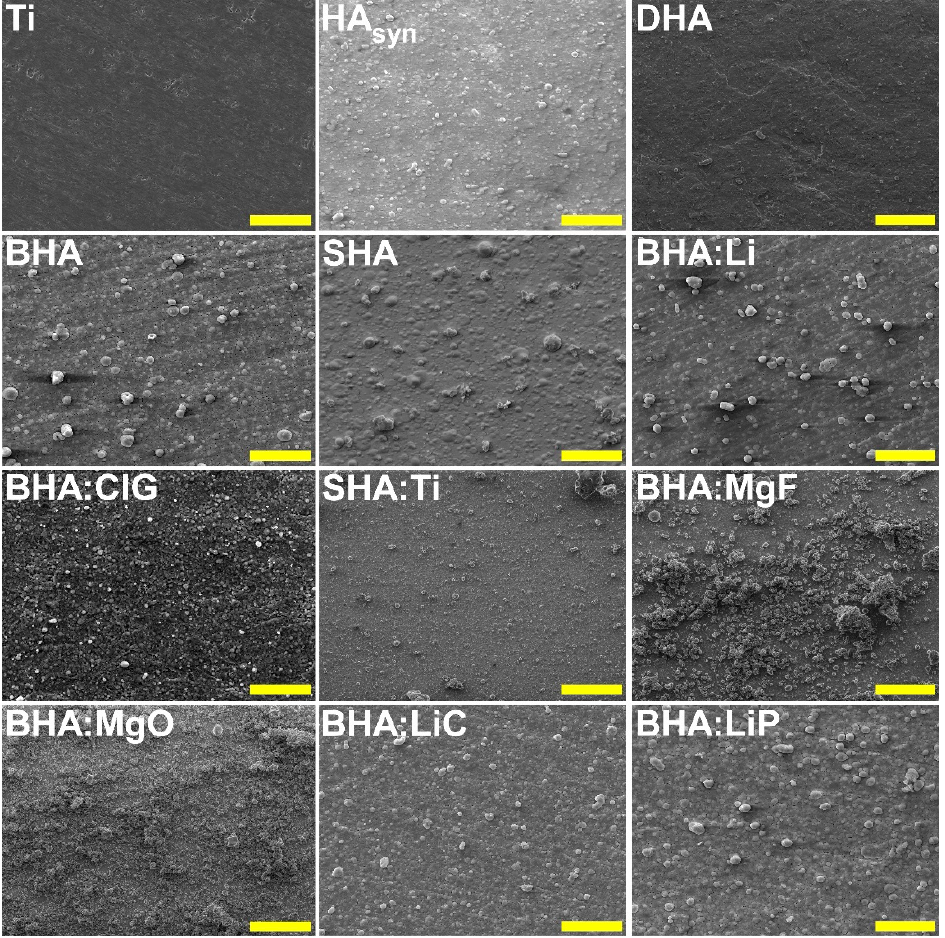
Figure 3. SEM micrographies corresponding to the surfaces of titanium and different types of BioHA coatings synthesized by PLD. Magnification bar: 50 μ m.